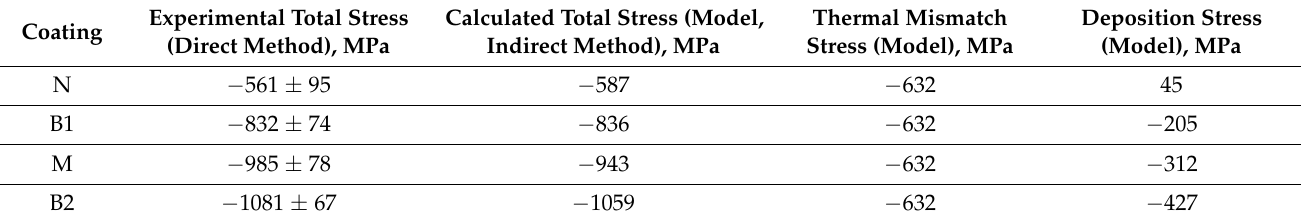
Table 6. Decomposition of the average stress in coating into contributions (total stress = thermal mismatch stress + deposition stress).